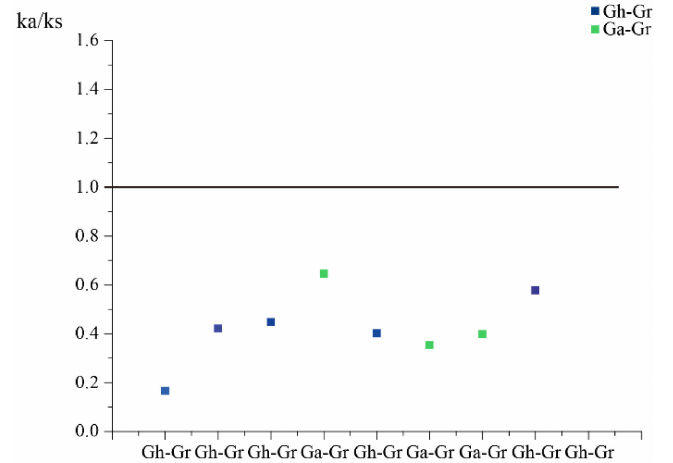
Figure 3. Analysis of Ka and KS ratio of three cotton species. The blue square stands for Gh-Gr; the green square stands for